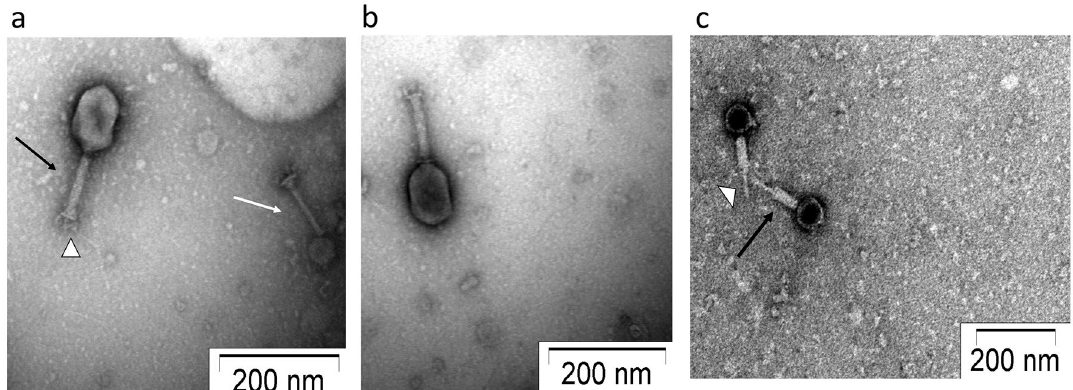
Figure 2. Transmission Electron micrographs of negatively stained phage particles from different areas on a grid. ( a , b ) Shows intact Myovirida e phage particles with uncontracted tail (black arrow) and base plate (arrowhead), broken tail (white arrow). ( c ) Phage particles with contracted tail sheath (black arrow) and protrusion of tail tubes (arrowhead). Purified phage particles were negatively stained using 2% (w/v) uranyl acetate and visualized using a TEM operating at a voltage of 100